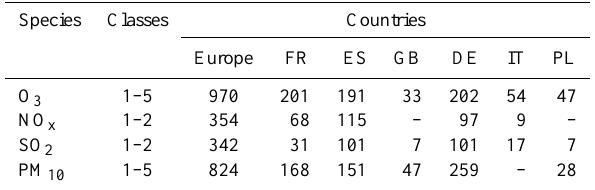
Table 5. Number of representative sites available by countries and species. Countries are, from left to right, France (FR), Spain (ES), England (GB), Germany (DE), Italy (IT) and Poland